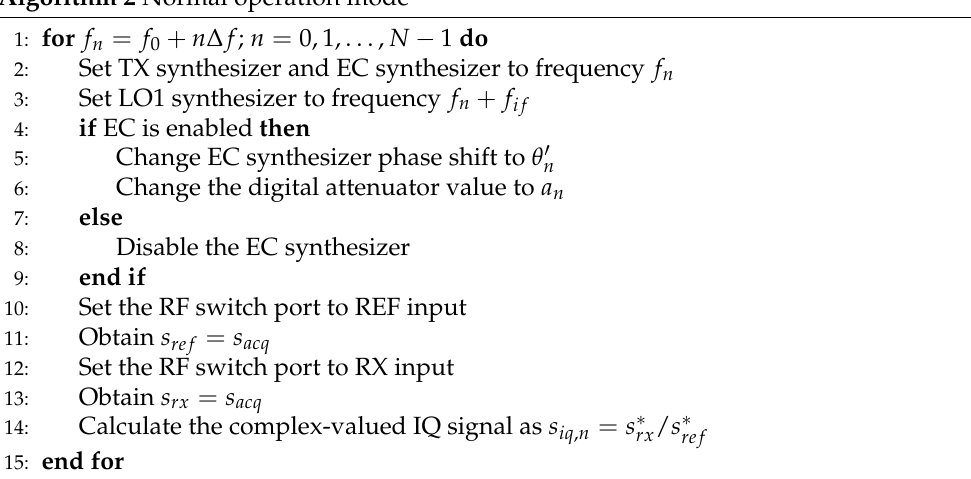
Algorithm 2 Normal operation mode